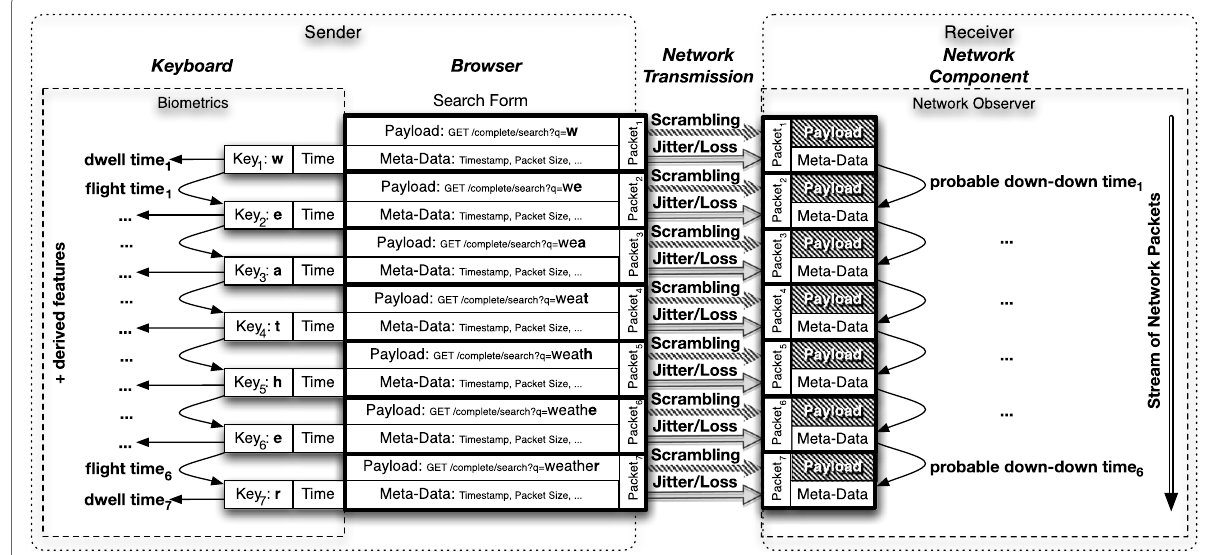
Fig. 1 Keystroke network transmission breakdown for word “weather” on hardware